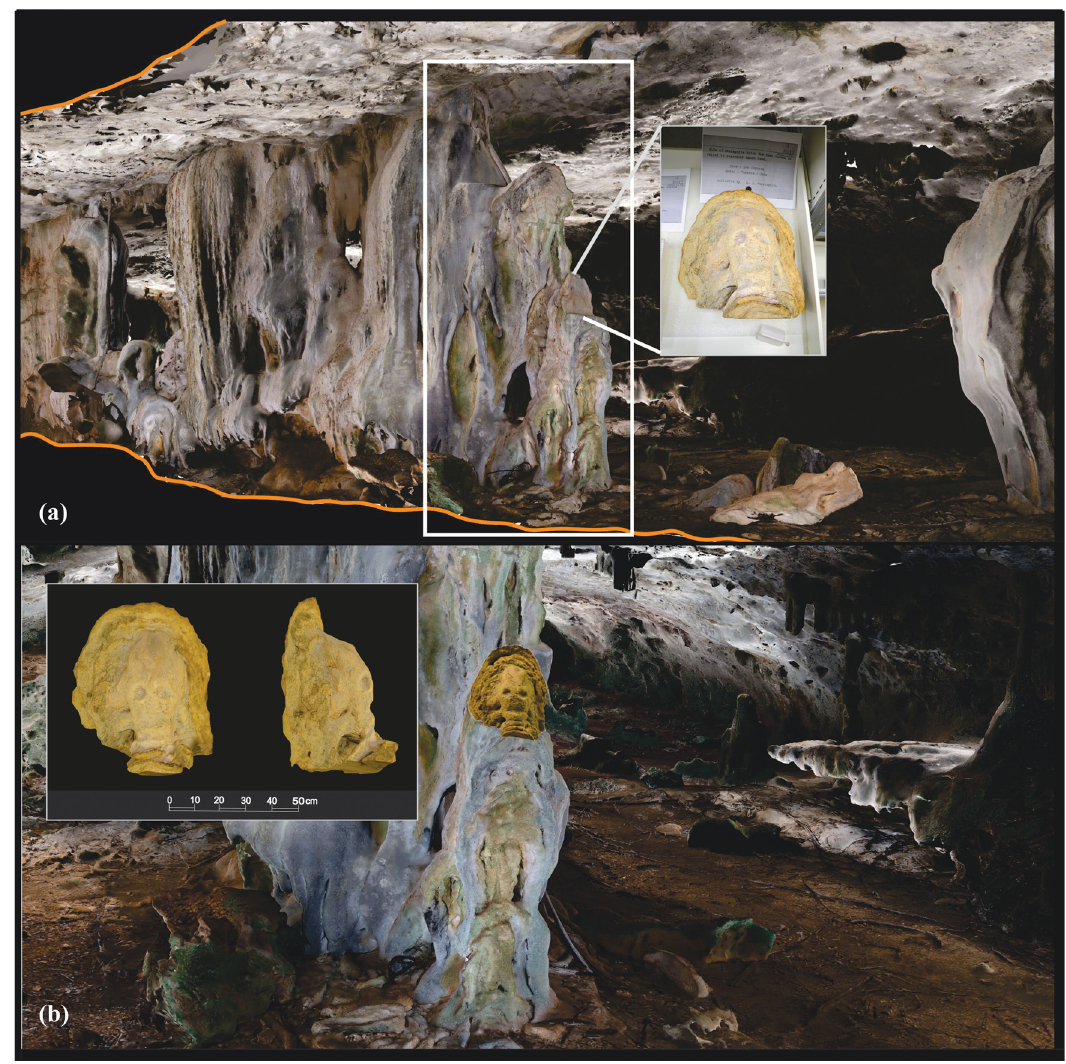
Figure 5: 3D modeling of the cut stalagmite ( a ) and the modeled petroglyph, currently at the Smithsonian Institution, USA ( b )